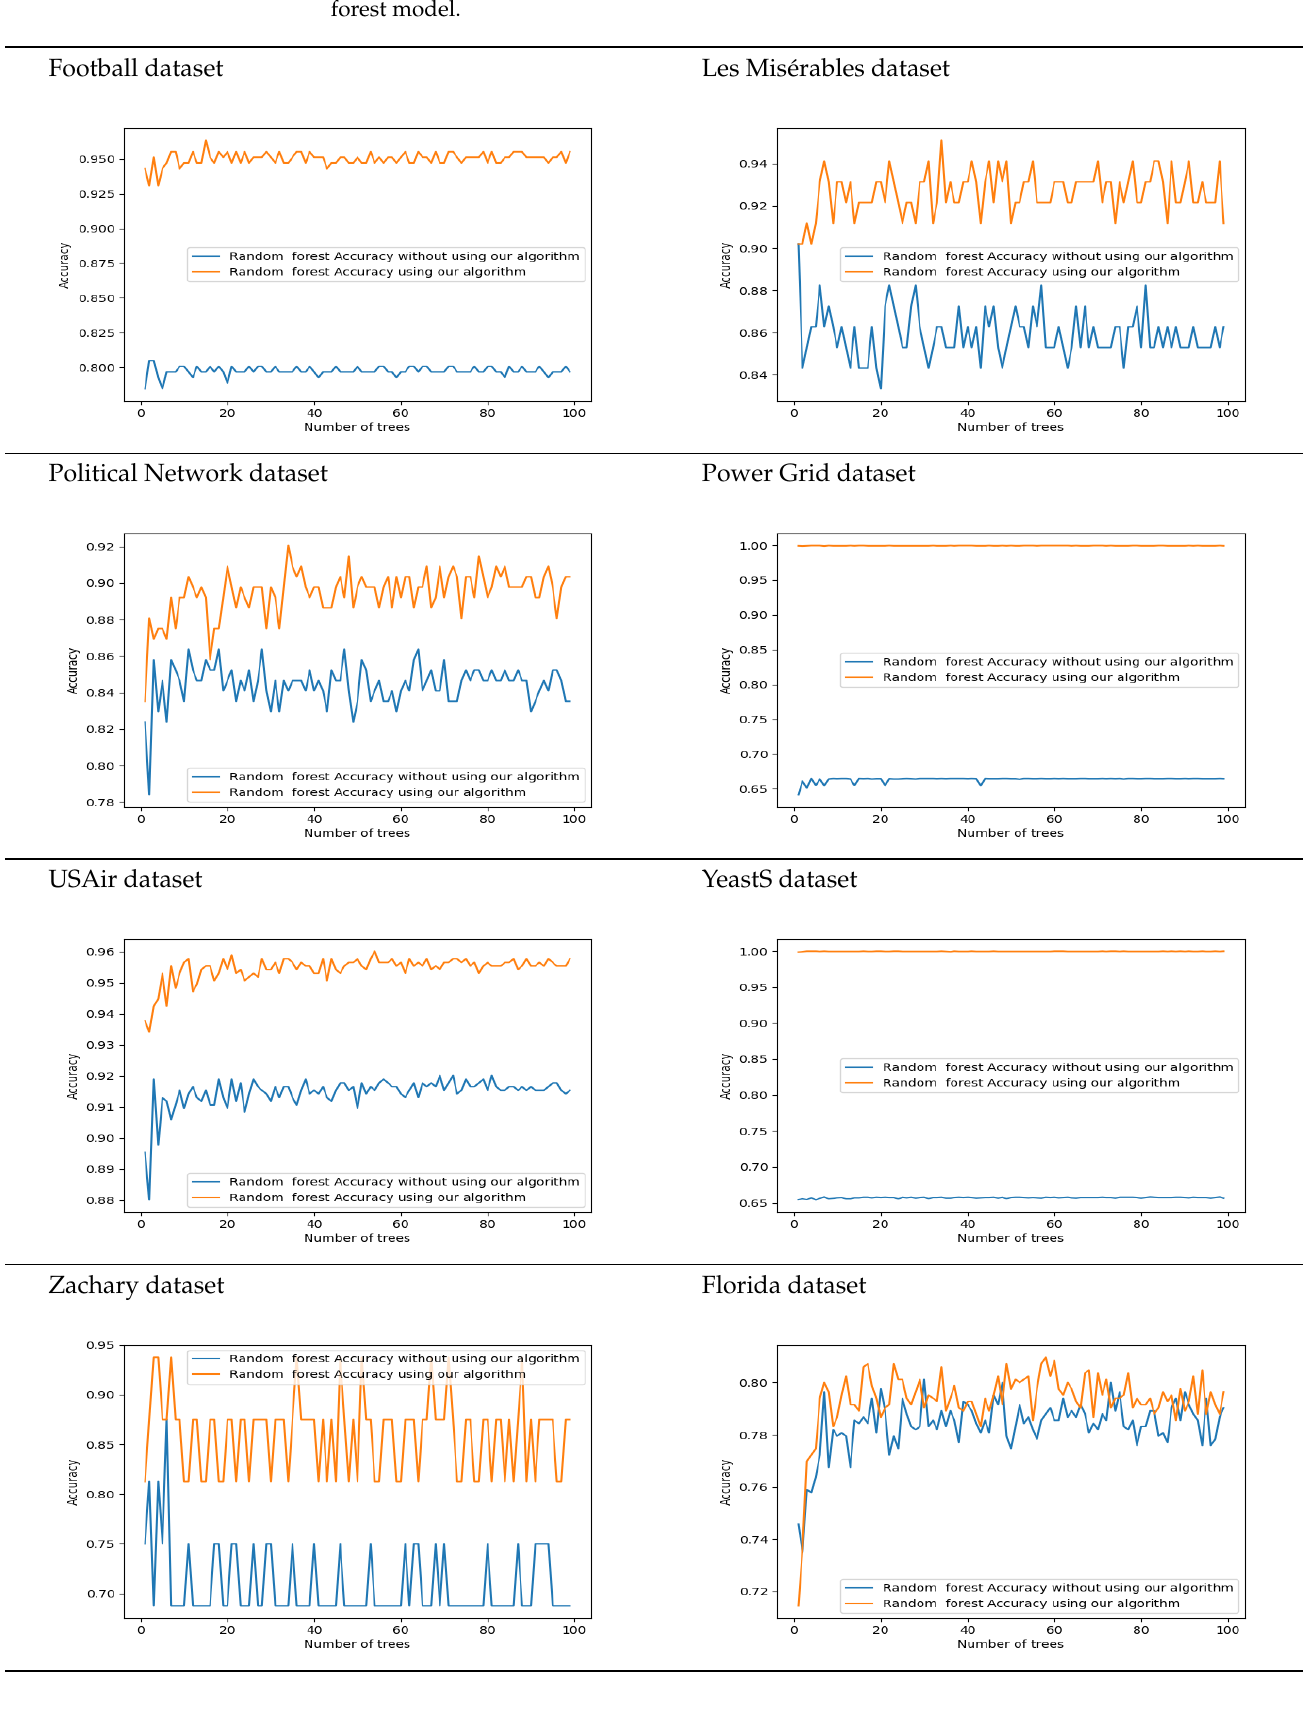
Table 8. The x axis represents the number of trees. The y axis represents the accuracy of the random forest